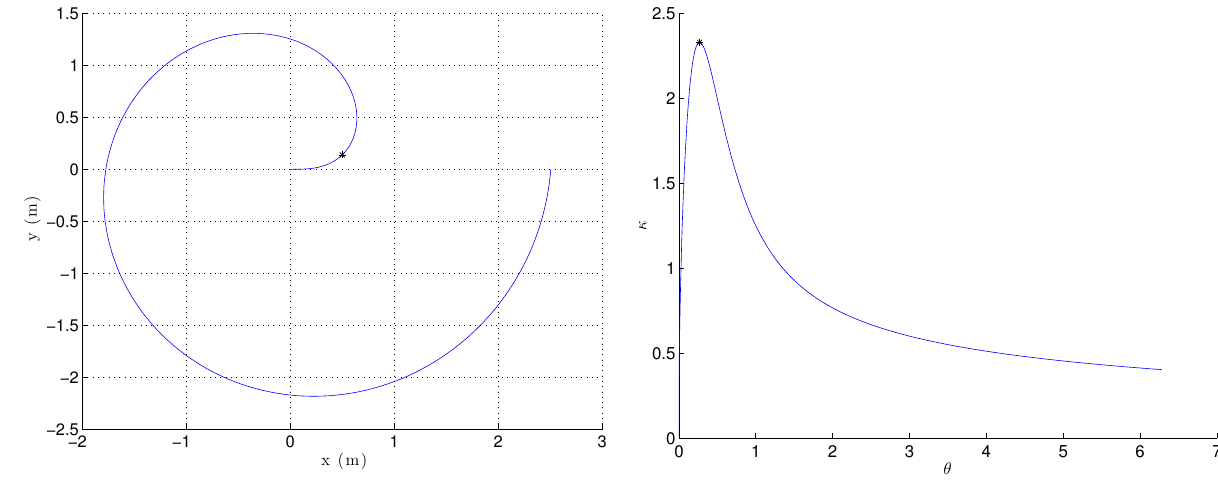
Figure 7: Fermat’s spiral, one complete rotation. The asterisk marks the point where the curve has the maximum curvature